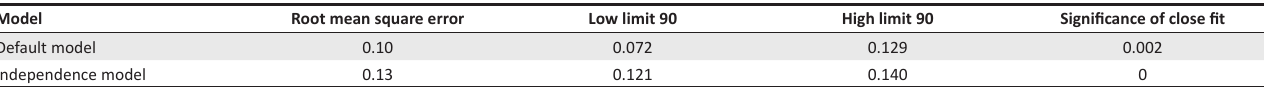
TABLE 6c: SEM model fit